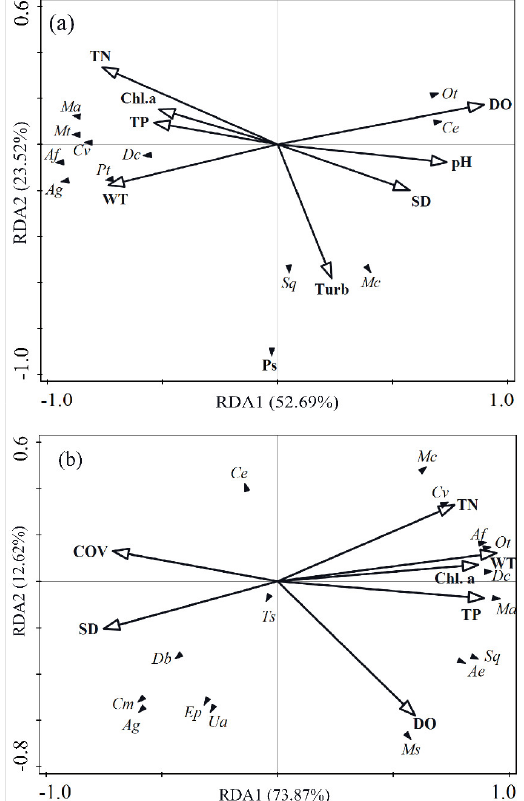
Figure 9. Redundancy analysis of the biomass of the dominant phytoplankton species (solid arrow) and the environmental factors (hollow arrow) before ( a ) and after ( b ) the aquatic vegetation